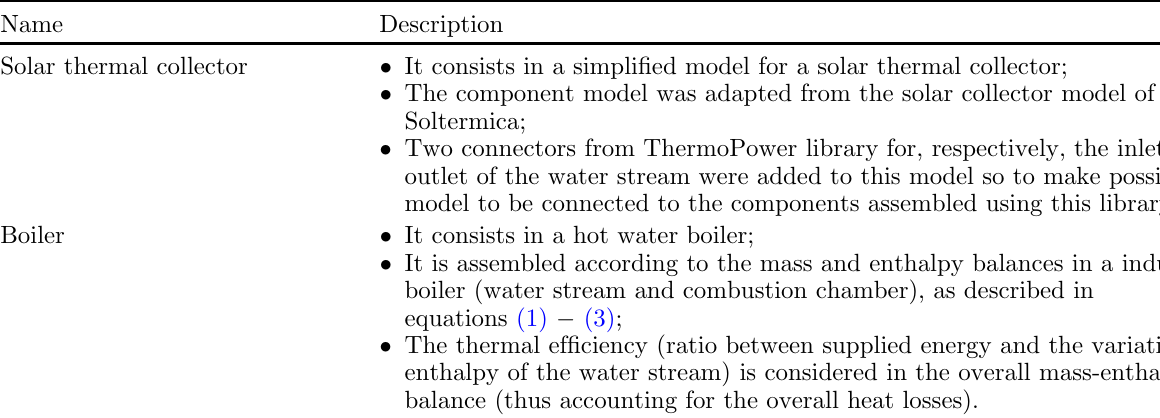
Table 3. Description of newly developed